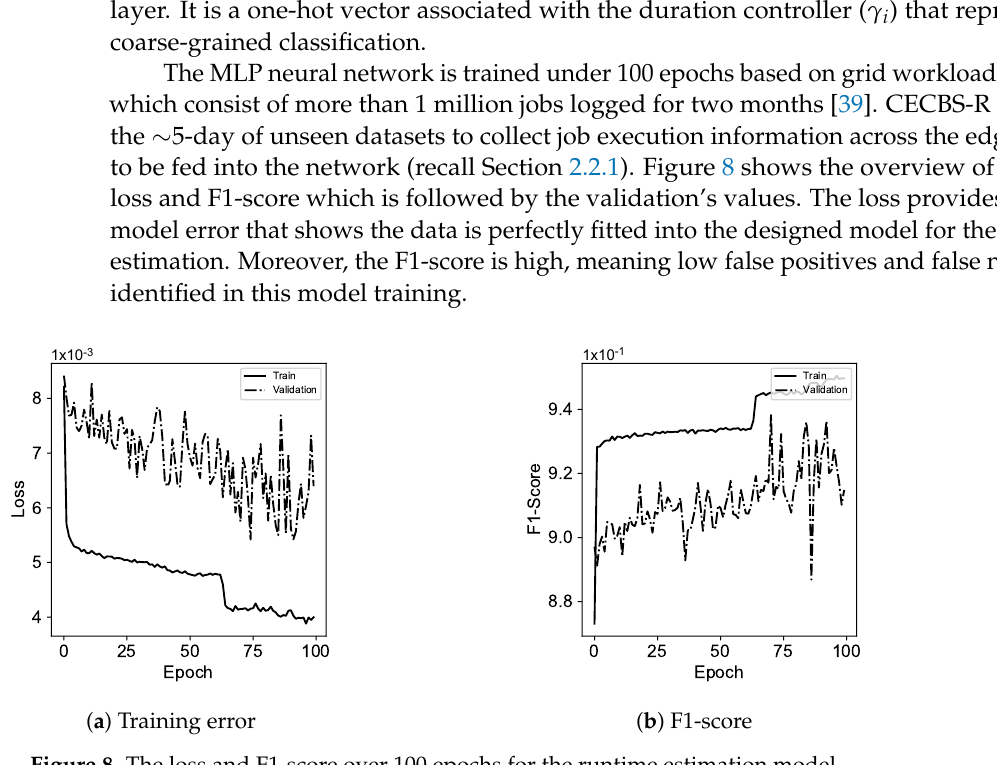
Figure 8. The loss and F1-score over 100 epochs for the runtime estimation model.